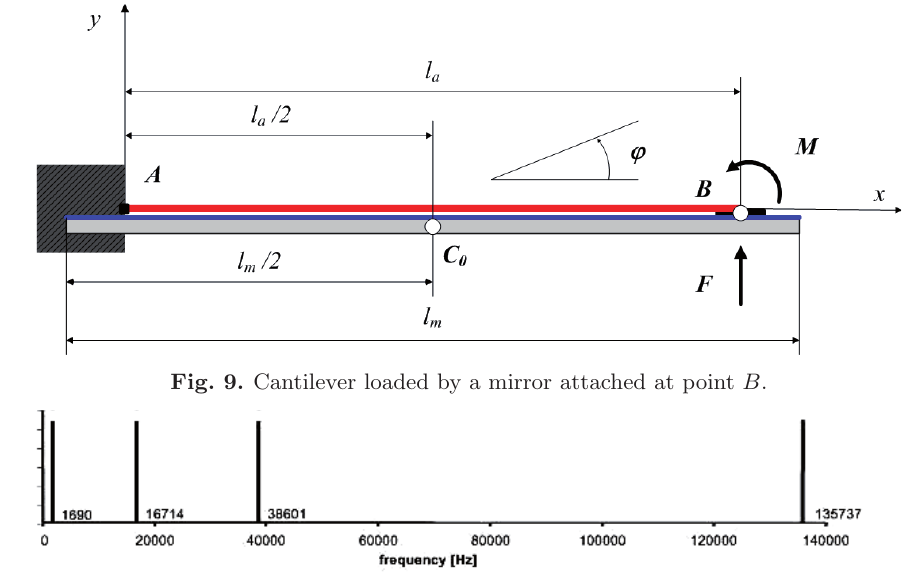
Fig. 10. The first four modes of the resonance frequency of the mirror.